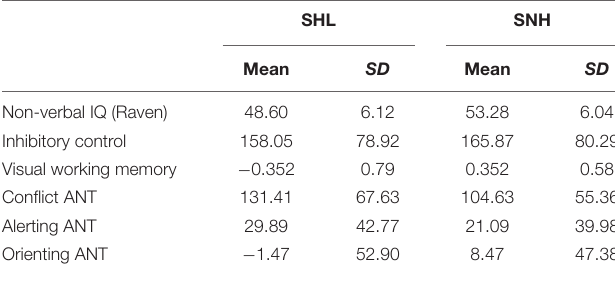
TABLE 2 | Mean scores on each task by hearing